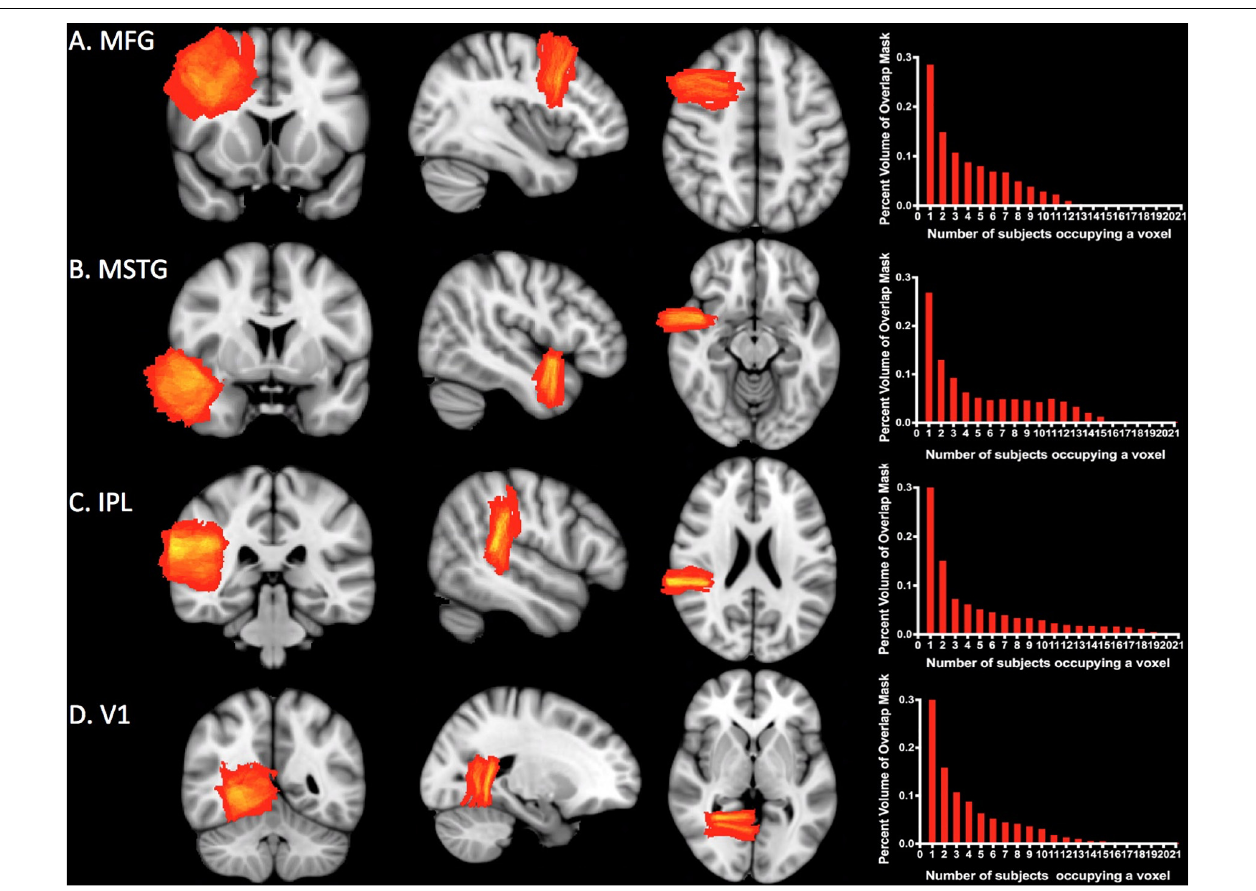
FIGURE 4 | Sampling precision. Heat maps and histograms conveying of the variation in sampling for each ROI. Each heat map shows the degree of overlap for the ROI. The red end of the spectrum represents less overlap and the yellow end represents greater overlap. The histograms illustrate the number of subjects whose simulated neuropathological blocks overlap in the MNI template space and the percentage of voxels with each degree of overlap. The maximum amount of overlap for any given voxel was only 12 of 35 subjects for MFG (A) , 15 of 35 for MSTG (B) , 21 of 35 for IPL (C) , and 15 of 35 for V1 (D) . Approximately 30% of each ROI mask was devoid of any overlap. MFG, middle frontal gyrus; MSTG, middle and superior temporal gyri; IPL, inferior parietal lobule; V1, primary visual